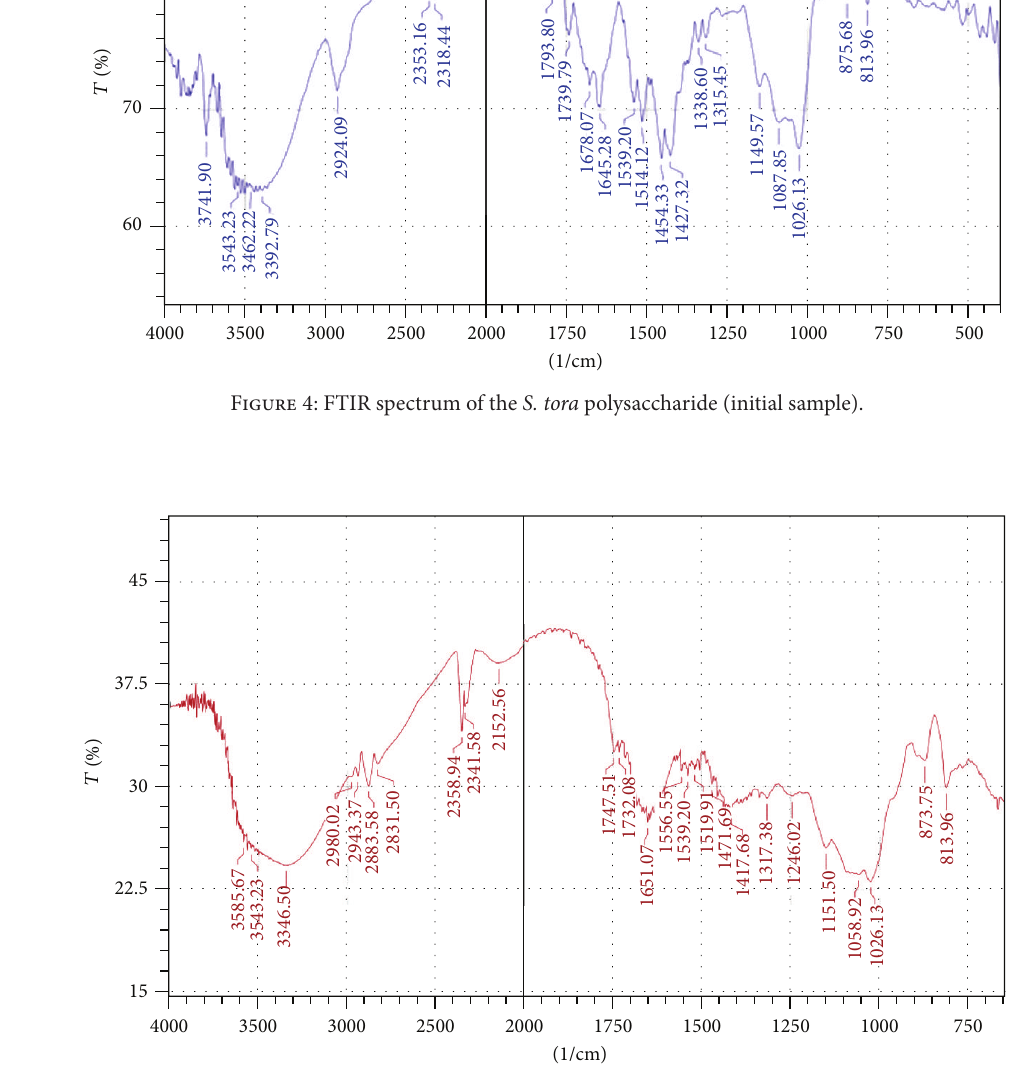
Figure 5: FTIR spectrum of the S. tora polysaccharide (after 6